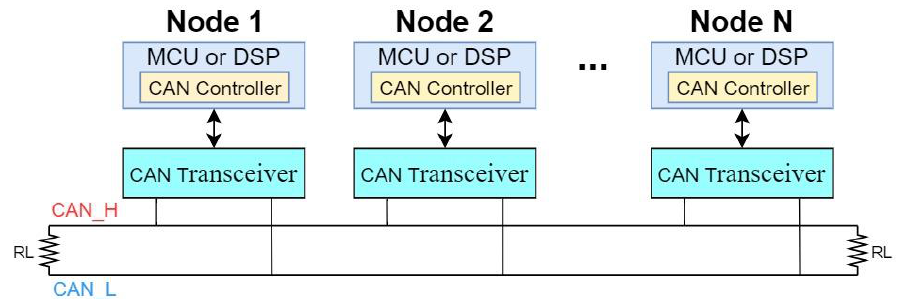
Figure 1. An example of a single two-wire Controller Area Network (CAN).